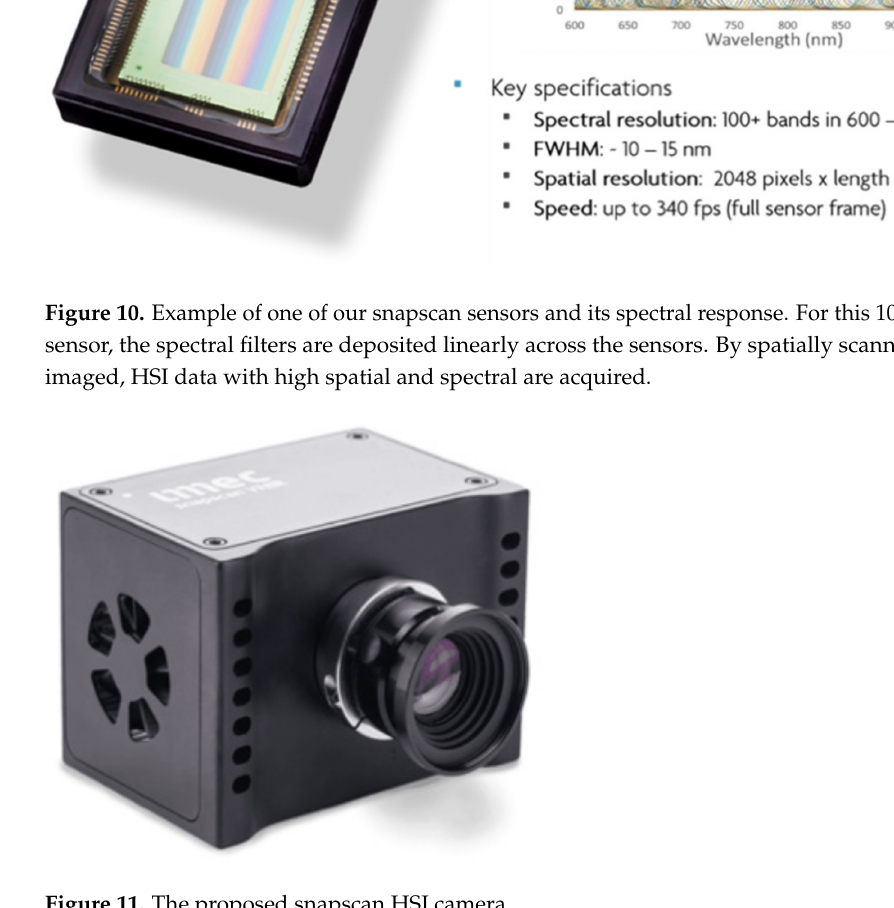
Figure 11. The proposed snapscan HSI camera.